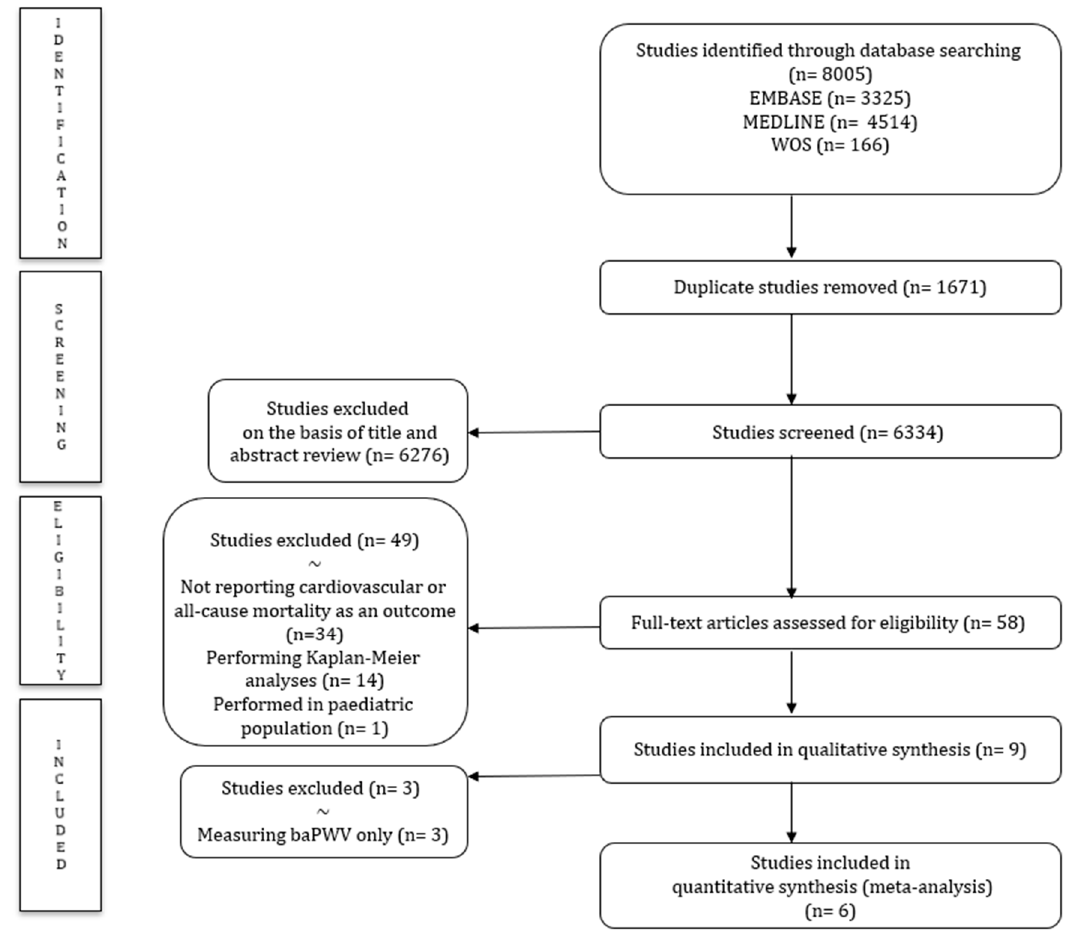
Figure 1. Preferred Reporting Items for Systematic Reviews and Meta-Analyses (PRISMA) diagram of the systematic literature search strategy.